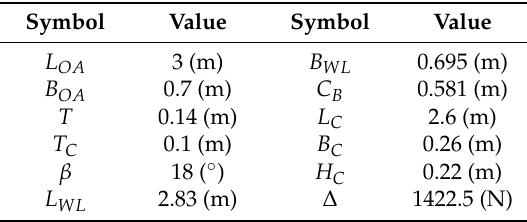
Table 1. Main dimensions of the PACSCAT model.